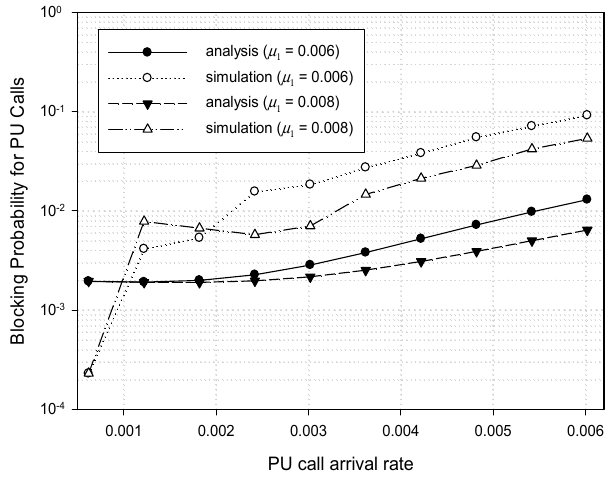
Figure 6. Blocking probability for PU calls.